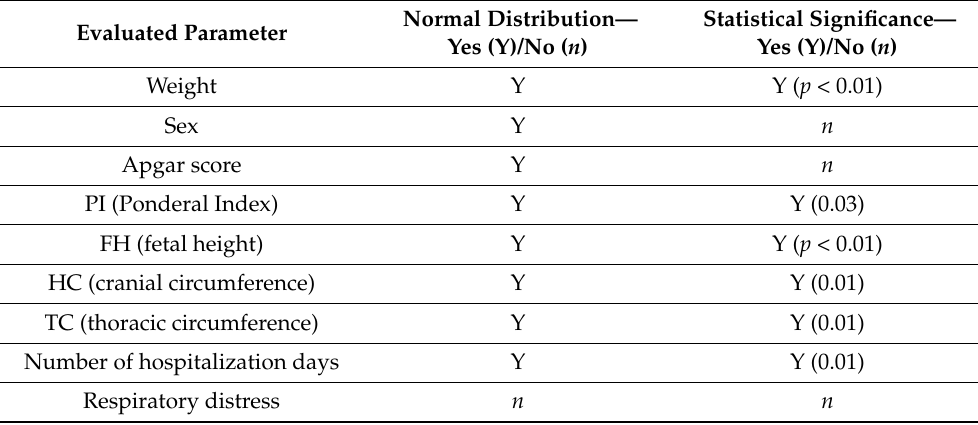
Table 2. The statistical distribution of the evaluated parameters. Evaluated